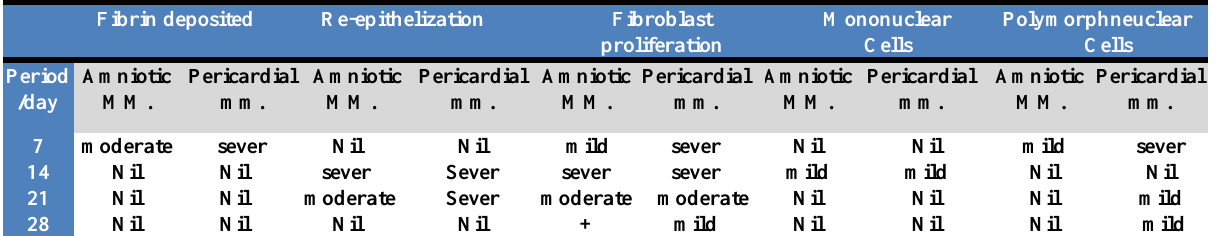
Table, 1: Shows the grades of histopathological evaluation of healing process in both amniotic and pericardial membranes. Fibrin deposited